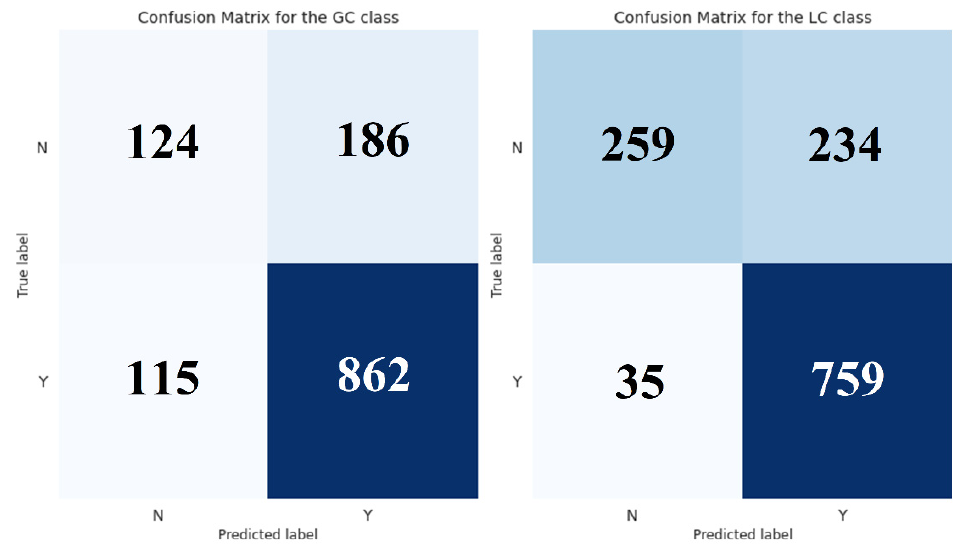
Figure 2. Confusion matrix—decision tree classifier. “Y” stands for “Yes”, indicating that a compound is amenable, while “N” stands for “No”, indicating that a compound is not amenable. Table 3. Classification report of rule ‐ based classifier.